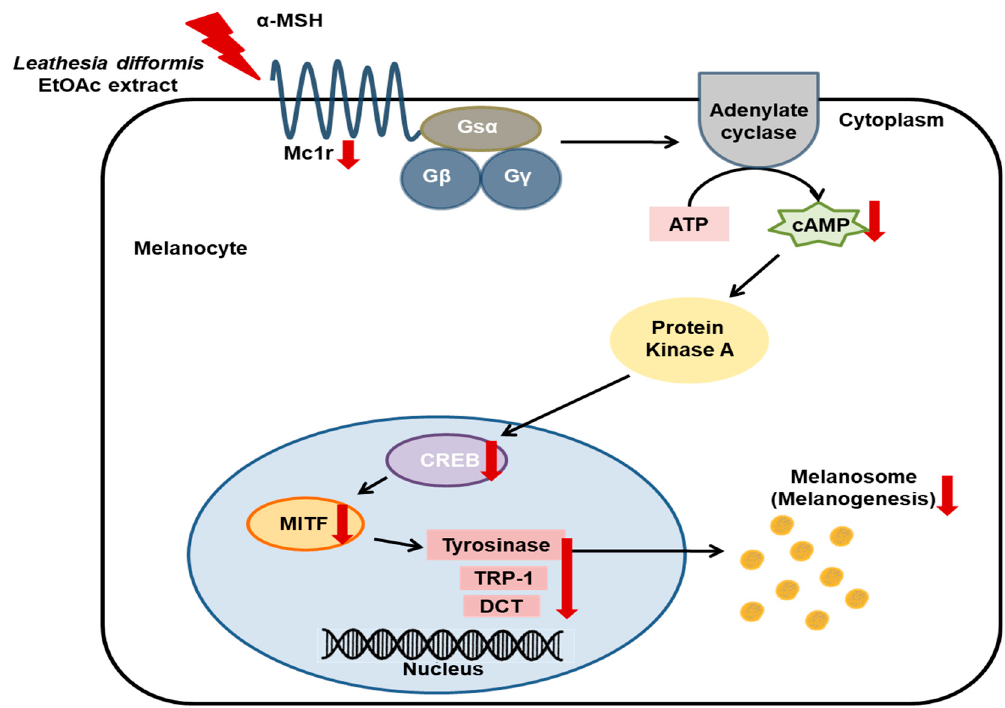
Figure 7. Proposed mechanism of EtOAc extract of L. difformis (LDE-EA) for inhibition of α -MSH-induced melanogenesis. Red polyline arrow indicates the treatment to melanocyte. Red arrows indicate the activity of LDE-EA and black arrows indicate the direction of regulation.